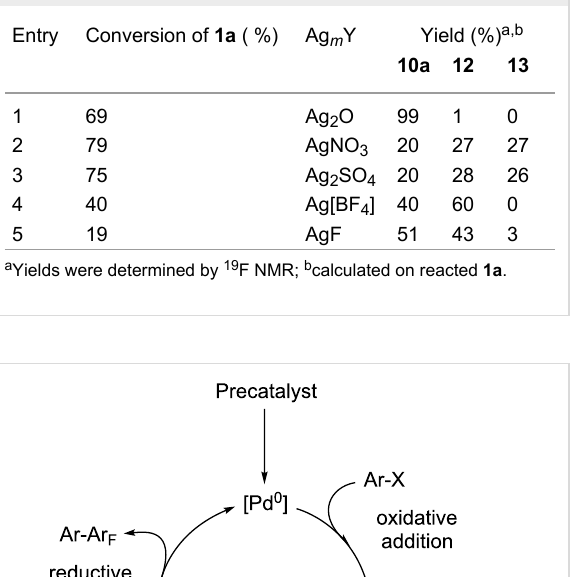
Table 4: Cross-coupling of 1a with 11 in the presence of different silver(I)